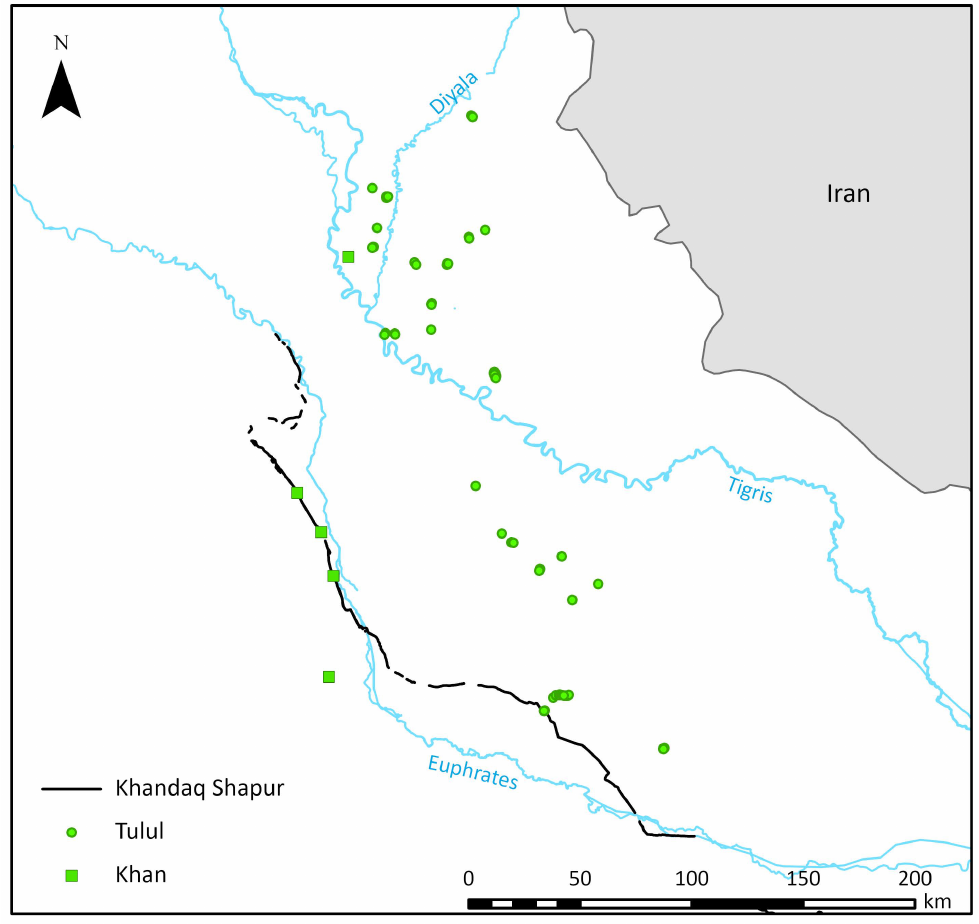
Figure 9. The Khandaq Shapur in relation to the Sasanian landscape of trade. Khans or caravanserais were locations where people travelling, including merchants, could stay overnight in a safe location with high walls and resupply on water from wells located in each courtyard. Three of the five sites identified as khans are located along the Khandaq Shapur, a fourth is located a few kilometers beyond towards the desert and the fifth is near the juncture between the Diyala and Tigris rivers.